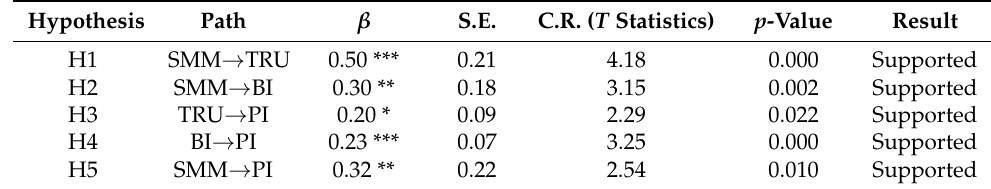
Table 5. Result of hypothesis testing using standardized estimates.